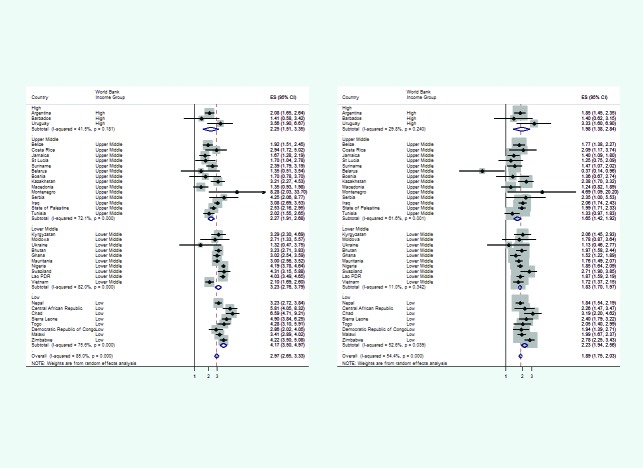
Funnels plot showing crude (left) and adjusted (right) risk ratios of the association between availability of children's book and being on track for Literacy-Numeracy Index (LNI) by World Bank Income Classification.